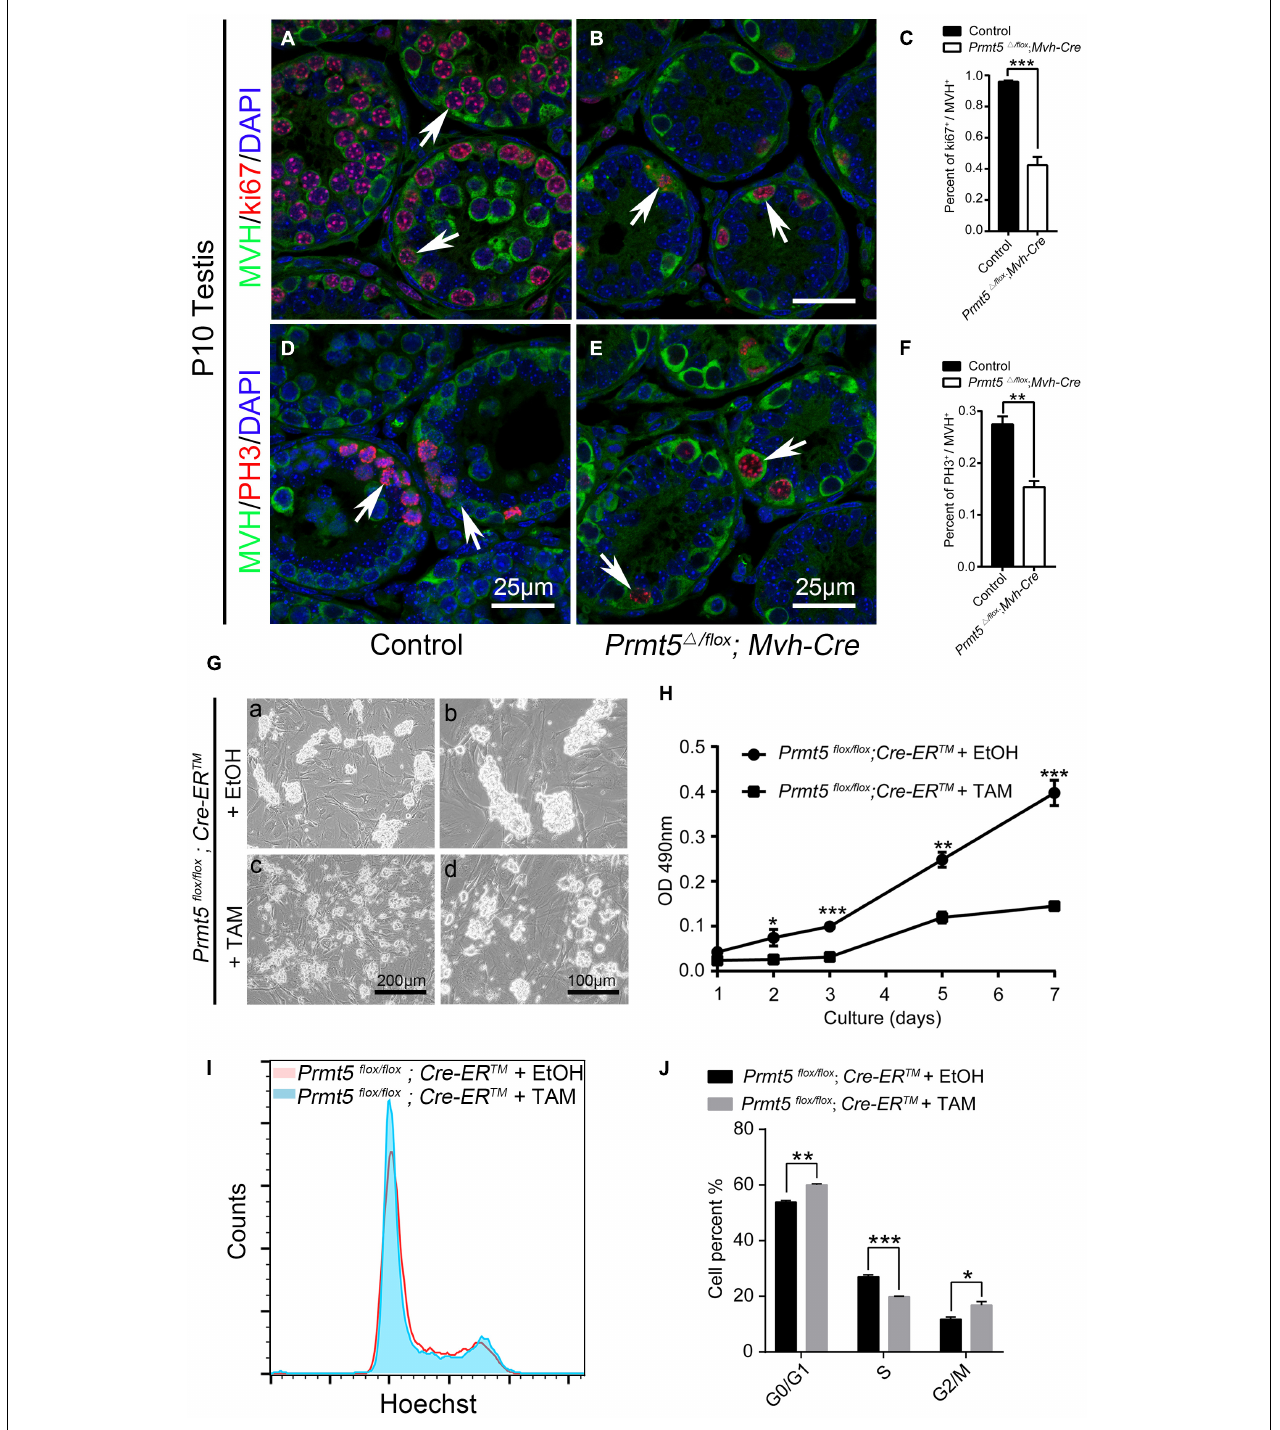
FIGURE 4 | Prmt5- deficient spermatogonial stem cells exhibit abnormal proliferation. Ki67-positive (red) germ cells were detected in both control [ (A) , white arrows] and Prmt5 (cid:49)/ flox ;Mvh-Cre testes [ (B) , white arrows] at P10. The percentage of Ki67-positive germ cells was dramatically reduced in Prmt5 (cid:49)/ flox ;Mvh-Cre mice (C) . PH3 (red) was detected in MVH-positive germ cells of both control [ (D) , white arrows] and Prmt5 (cid:49)/ flox ;Mvh-Cre testes [ (E) , white arrows] at P10. The percentage of PH3-positive germ cells was dramatically reduced in Prmt5 (cid:49)/ flox ;Mvh-Cre mice (F) . (G) Bright-field images of control and Prmt5- deficient SSCs cultured in vitro. Prmt5 flox / flox ;Cre-ER TM SSCs were treated with ethanol or 1 µ M tamoxifen to induce Cre activation. (H) MTT assay of cultured control and Prmt5- deficient SSCs. (I) FACS analysis of cultured control and Prmt5- deficient SSCs. (J) Quantitative analysis of cells in G0/G1, S, and G2 phase. Error bars represent the SEM of triplicate results. * P < 0.05, ** P < 0.005, *** P < 0.0005 indicates a significant difference ( t -test).